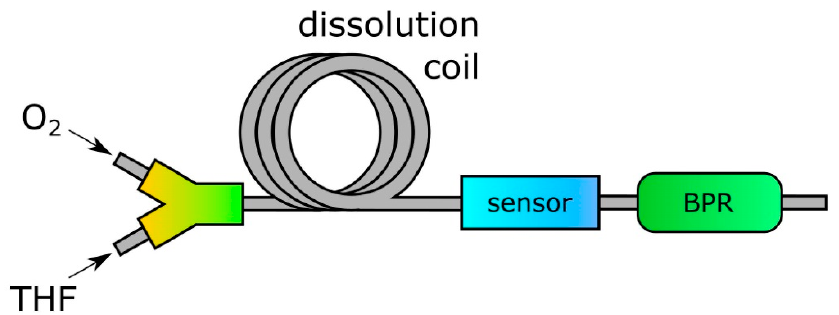
Figure 2. Reactor scheme of the sensor calibration step including Y-piece, dissolution coil, sensor and back pressure regulator.